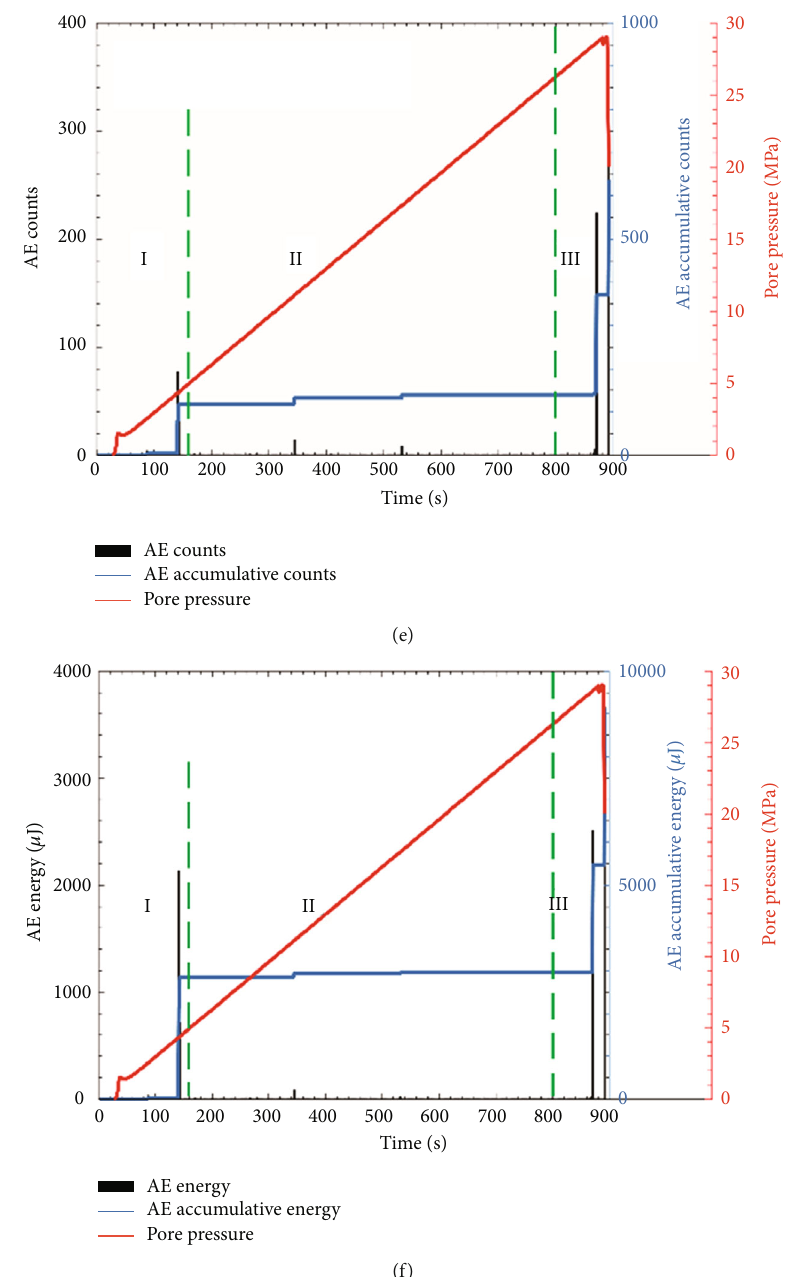
Figure 5: Plots of the relationship of AE counts/accumulative counts, AE energy/accumulative energy, and loading pore pressures for the vertical samples T1, T2, T3. (a, b) Plots of sample T1. (c, d) Plots of sample T2. (e, f) Plots of sample T3. The green dashed lines roughly indicate the three stages (I: initial stage; II: quiet stage; and III: fracturing stage) of the fracturing